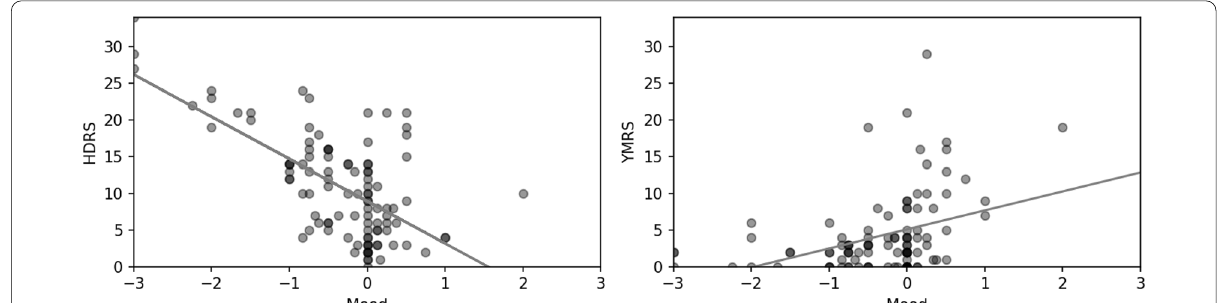
Fig. 2 The association between Hamilton Depression Rating Scale 17‑items score (HDRS), Young Mania Rating Scale (YMRS) and patient‑reported smartphone‑based data on mood. The grey line indicates the linear least square fit for each